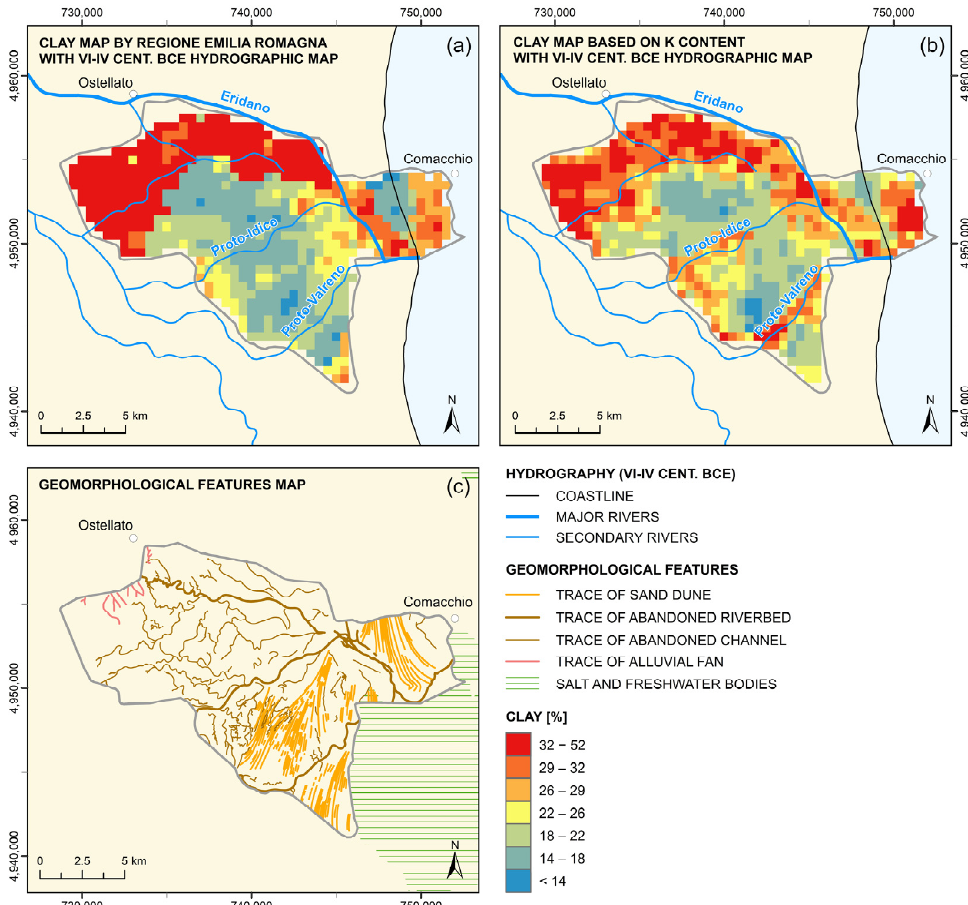
Figure 9. Hydrographic network of the VI-IV century BCE [30] superimposed on ( a ) the clay content map provided by RER and ( b ) the clay content map as predicted by the NLML model. ( c ) The geo-morphological feature map provided by RER. Cartographic reference system: WGS 84, UTM Zone 32N.